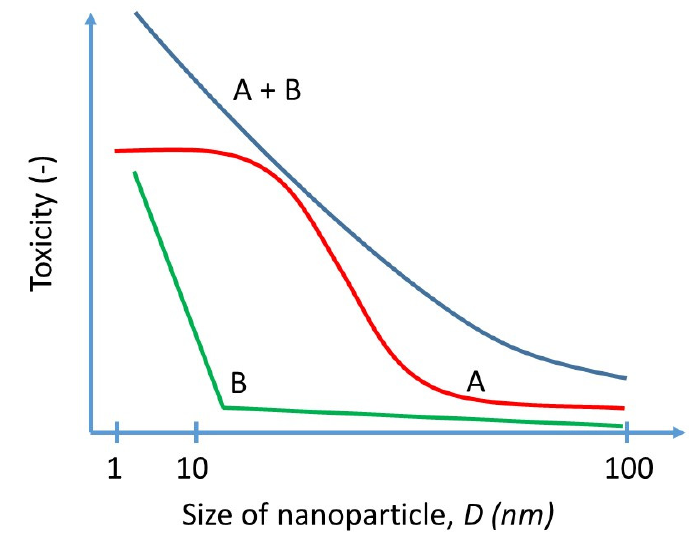
Figure 1. Theoretical estimate of the size and toxicity relationship. A: sigmoidal curve; progressive dependence of toxicity with decreasing size down to a certain saturation limit. B: threshold curve; a small change of the particle size results in a large increase of toxicity below a certain critical size (a threshold). A + B: synthesis of both approaches; the toxicity grows with decreasing particle size. Note: the toxicity axis has no unit in this graph as it is a tentative scale for displaying general trends in toxicity change with NP diameter. Table 1. Comparison of size–toxicity results from different